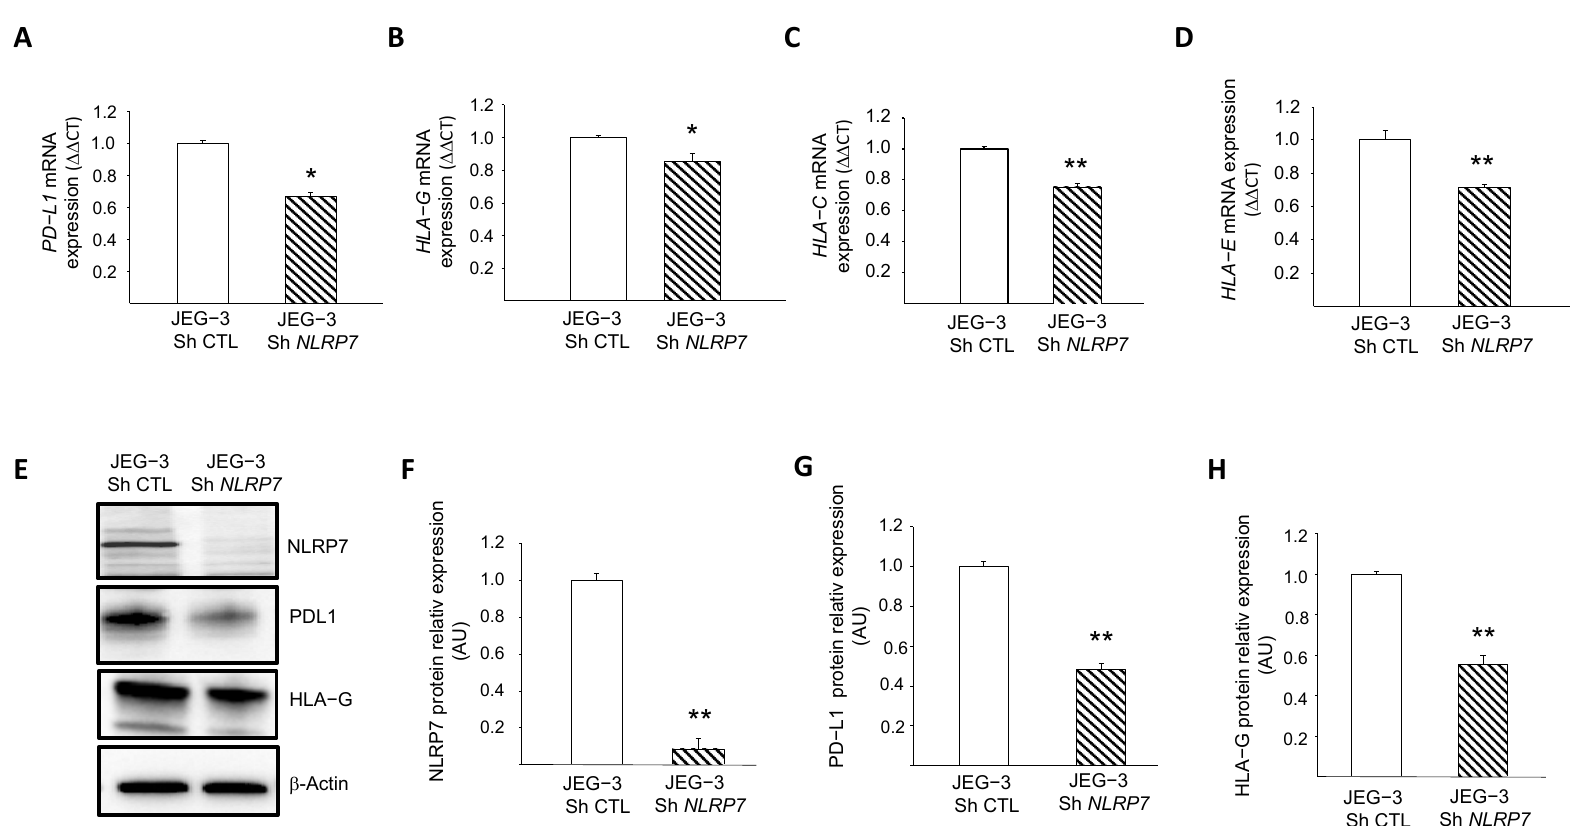
Figure 5. Characterization of the role of NLRP7 in the camouflage of JEG-3 cells. ( A ) reports a comparison of the mRNA levels of PD-L1 expression in JEG-3 Sh CTL and JEG-3 Sh NLRP7 ( n = 3); * p < 0.05. ( B ) reports a comparison of the mRNA levels of HLA-G expression in JEG-3 Sh CTL and JEG-3 Sh NLRP7 ( n = 3); * p < 0.05. ( C ) reports a comparison of the mRNA levels of HLA-C expression in JEG-3 Sh CTL and JEG-3 Sh NLRP7 ( n = 3); ** p < 0.01. ( D ) reports a comparison of the mRNA levels of HLA-E expression in JEG-3 Sh CTL and JEG-3 Sh NLRP7 ( n = 3); ** p < 0.01. ( E ) reports a comparison of NLRP7, PD-L1 and HLA-G protein levels in JEG-3 Sh CTL and JEG-3 Sh NLRP7 cells. ( F ) reports a quantification of the NLRP7 protein levels ( n = 3); ** p < 0.01. Standardization of protein signals was performed using antibodies against β − actin. ( G ) reports a quantification of the PD-L1 protein levels ( n = 3); ** p < 0.01. Standardization of protein signals was performed using antibodies against β -actin. ( H ) reports a quantification of the HLA-G protein levels ( n = 3); ** p < 0.01. Standardization of protein signals was performed using antibodies against β −